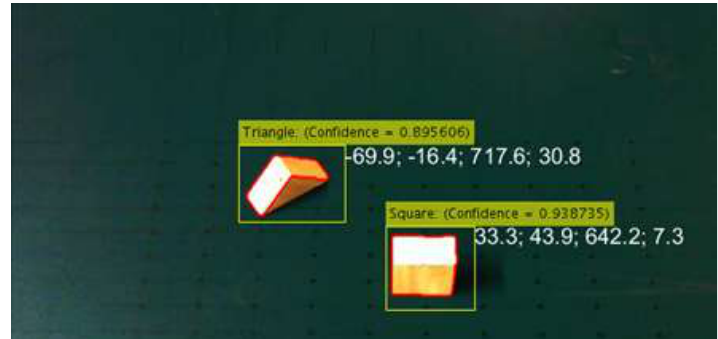
Figure 14. Estimation results of two object names and positions and their orientations.